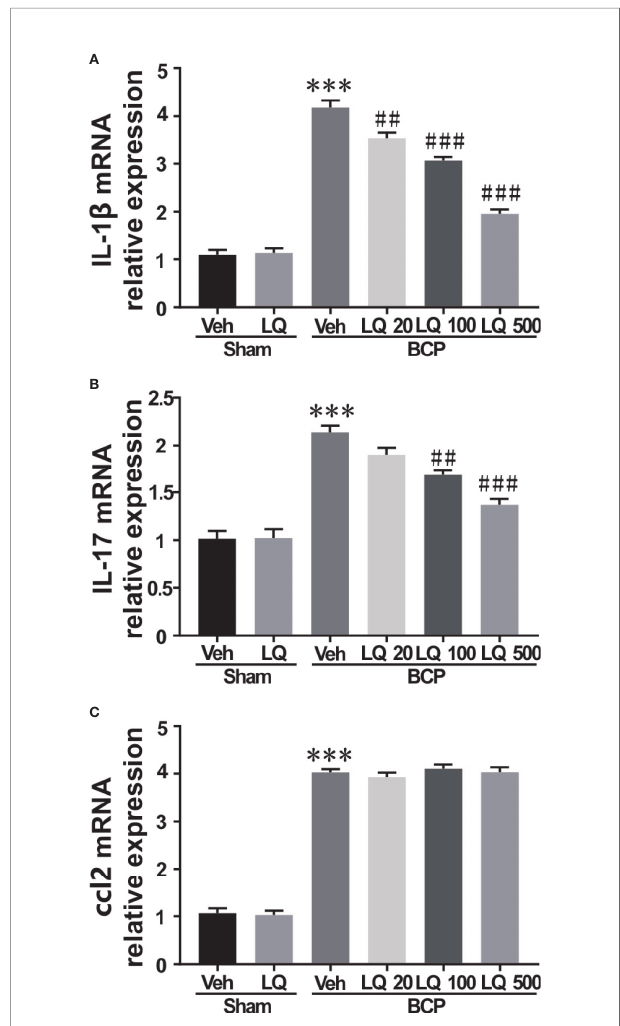
FIGURE 7 | Effects of intrathecal injection ofLiquiritin (LQ) on bone cancer pain (BCP)-induced upregulation ofIL-1 b , IL-17, and ccl2levelsinspinal dorsalhorn were revealed by RT-PCR. (A – C) RT-PCR showed noremarkable differences regarding the levels of IL-1 b , IL-17, and ccl2 between the sham + Veh group and sham + LQ 500 m g/kggroup (F 5,18 = 138.6, P > 0.05 vs. sham +Veh group; F 5,18 = 41.14, P > 0.05 vs. sham +Veh group; F 5,18 = 284.8, P > 0.05 vs. sham +Veh group; n = 4, one way ANOVA, 7A – C ). A signi fi cant upregulation of levelsof IL-1 b , and IL-17 as wellas chemokineccl2were observed in BCP, and were increased by3.80-, 2.11-, and 3.78-folds, respectively,on day 12 after injection ofwalker 256 cells (F 5,18 = 138.6, ***P < 0.001 vs. sham +Veh group; F 5,18 = 41.14, ***P < 0.001 vs. sham +Veh group; F 5,18 = 284.8, ***P < 0.001 vs. sham +Veh group; n = 4, one way ANOVA, 7A – C ). Only IL-1 b mRNA was decreased inthe LQ20 m g/kg group (F 5,18 = 138.6, ## P < 0.01 vs. BCP + Veh group; n = 4, one way ANOVA, 7A ). (A , B) LQ100 m g/kgdecreased the expression of IL-1 b andIL-17 mRNA to 73.41% and78.83%, respectively, when compared with BCP groupinjected with vehicle (F 5,18 = 138.6, ### P < 0.001 vs. BCP + Veh group, F 5,18 = 41.14, ## P < 0.01 vs. BCP + Veh group;n = 4, one way ANOVA, 7A, B ). (A , B) Under the management of LQ500 m g/kg, the expression of IL-1 b andIL-17 mRNA was decreased to 46.83% and64.21% (F 5,18 = 138.6, ### P < 0.001 vs. BCP + Veh group, F 5,18 = 41.14, ### P < 0.001 vs. BCP + Veh group;n = 4, one way ANOVA, 7A, B ). (C) No signi fi cant decrease was observed in the levelsof ccl2 after the three concentrationsof LQ administration following BCP surgery(F 5,18 = 284.8, ***P < 0.001 vs. sham +Veh group, P > 0.05 vs. BCP + Veh group; n = 4, one way ANOVA, 7C